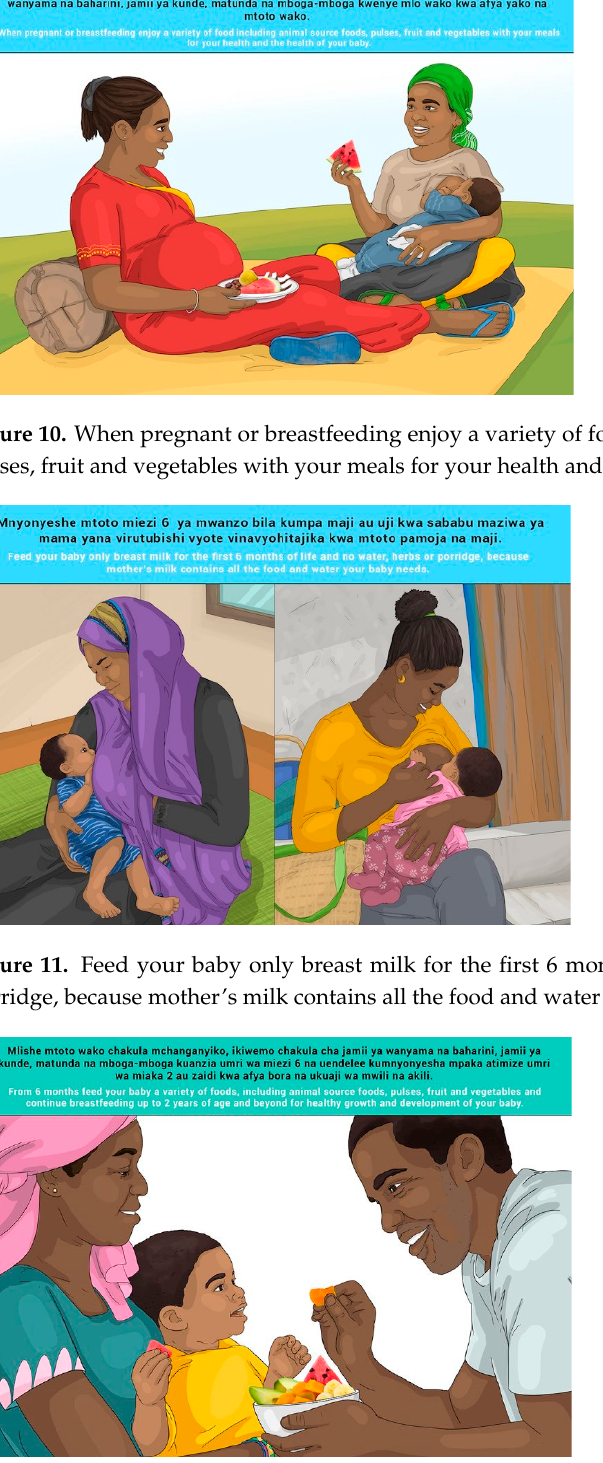
Figure 13. Encourage school-aged children to eat healthy snacks such as fresh fruit, vegetables and nuts.